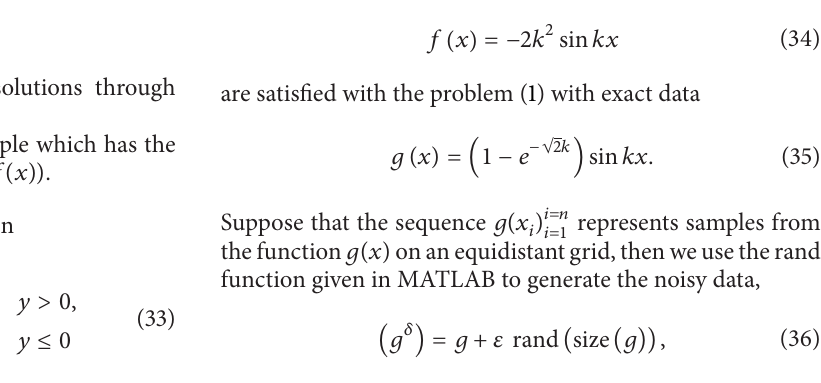
Figure 2: Comparison between the exact solution and its computed approximations with 𝑘 = 2 and various noise levels of 𝜀 = 0.01 , 𝜀 = 0.001 , 𝜀 = 0.0001 for Example 5.